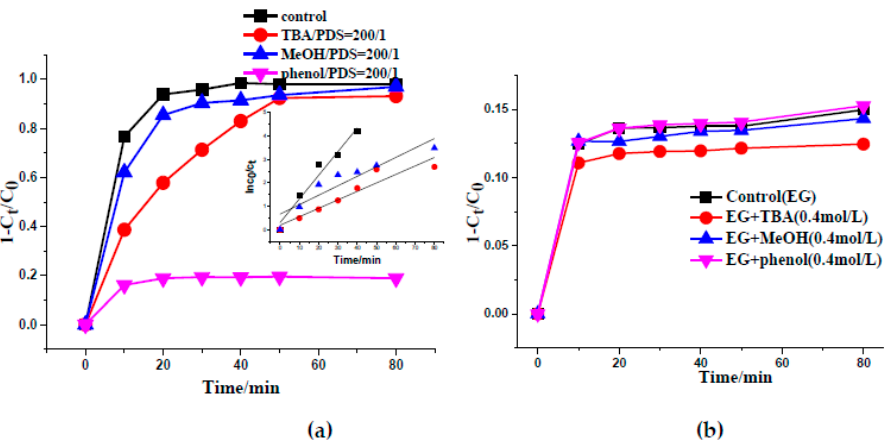
Figure 5. ( a ) Degradation and ( b ) adsorption of AR97 in the presence of different radical scavengers. [AR97] 0 = 50 mg × L − 1 ; [PDS] 0 = 2 mmol × L − 1 ; [EG2] 0 = 1 g × L − 1 ; pH = 6.9; [TBA] 0 = 0.4 mol × L − 1 ; [MeOH] 0